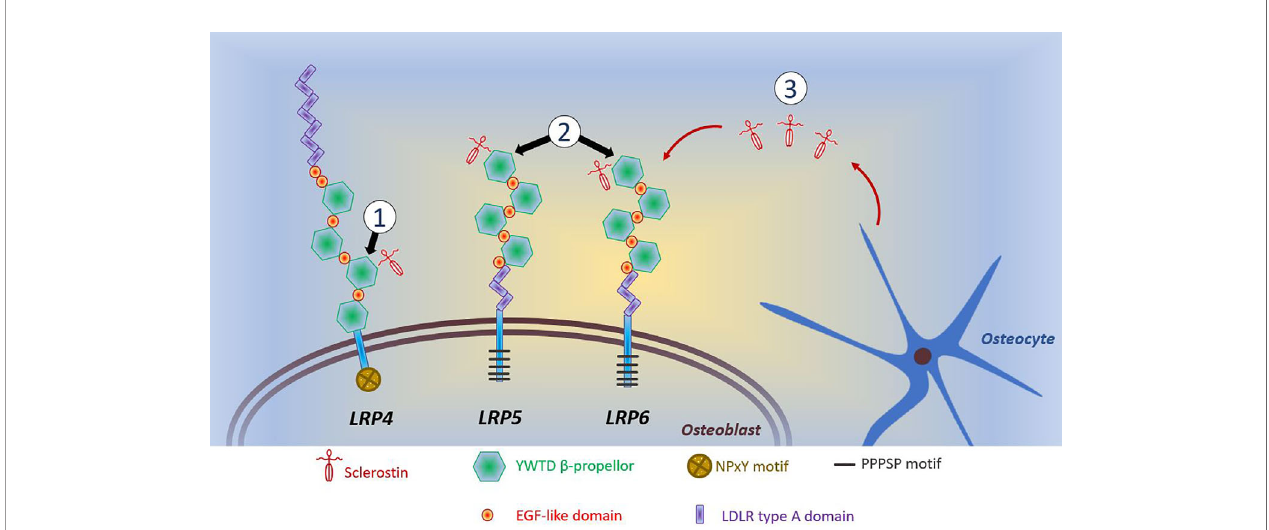
FIGURE 1 | Schematic diagram of reported mutations affecting osteoblastic Wnt signaling. (1) LRP4 mutations coding for the 3 rd b -propellor impair sclerostin binding; (2) LRP5 and LRP6 mutations coding for the 1 st b -propellor impair sclerostin binding; (3) SOST mutations inhibit sclerostin production by osteocytes. Reductions in the inhibitory effects of sclerostin allows LRP5/6 to interact with Wnt and its co-receptor Frizzled, which prevents phosphorylation of b -catenin allowing it to accumulate in the cytoplasm of the osteoblast. Translocation of b -catenin to the nucleus activates transcription of target genes. This activation of canonical Wnt/ b -catenin signaling increases osteoblastic bone formation. The intracellular consequences of LRP4-sclerostin binding are less well characterized; however, reductions in LRP4-sclerostin binding have a similar effect to increase osteoblastic bone formation. LDLR, low-density-lipoprotein receptor. LRP, LDLR related proteins; PPPSP, Proline, Proline, Proline, Serine, Proline; EGF, epidermal growth factor; NPxY, Aspartate, Proline, any amino acid, Tyrosine; YWTD, Tyrosine, Tryptophan, Threonine,